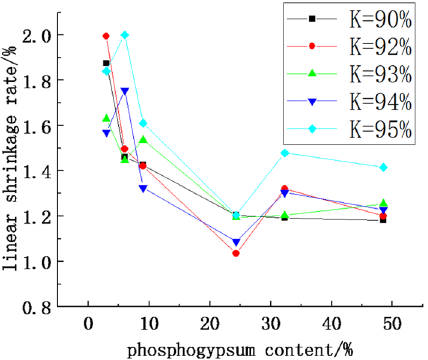
Fig. 6 Relationship between absolute expansion rate of mixture and phosphogypsum content (5% cement)